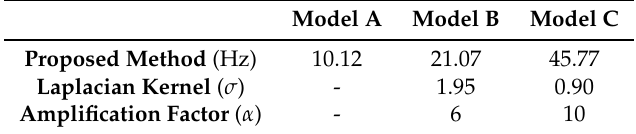
Table 2. Identified modal frequencies and analysis parameters in the noise barrier